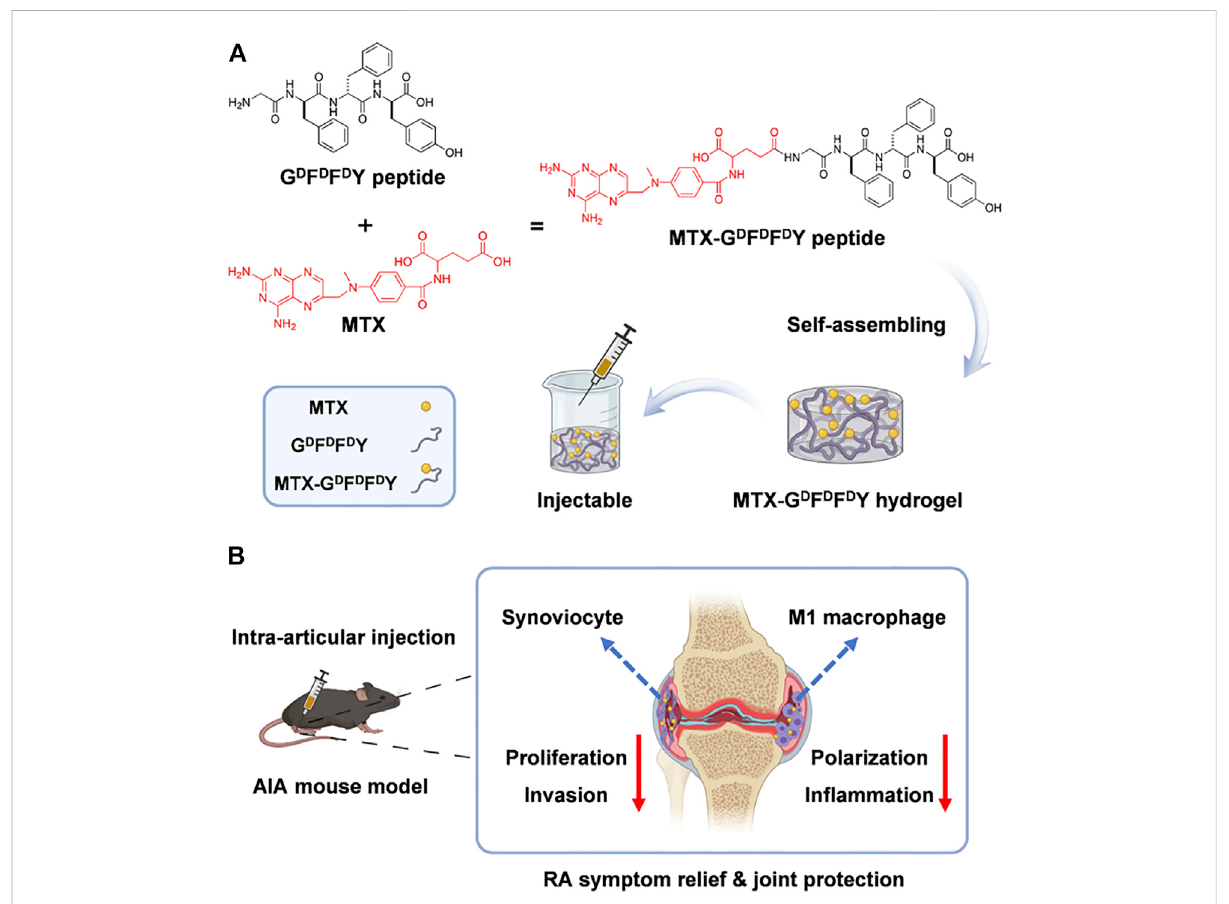
FIGURE 1 ThesynthesisofMTX-G D F D F D Yhydrogelsandtheiruseinthetreatmentofrheumatoidarthritis(RA)areshownschematically. (A) Theinteraction of the carboxyl groups in MTX with the deaminated glycine in peptides results in the conjugation of MTX with G D F D F D Y peptides. And the peptides could forminjectablehydrogels throughthestackingof π - π . (B) After beingintra-articularly injected into theknee joints ofadjuvant-induced arthritis (AIA)mice,thehydrogelscanconstantlyreleaseMTXduringbiodegration,andthusinhibitnotonlythepoliferationandinvasionofsynoviacytes, but also the polarization of poim fl ammtory M1 type macrophages, achieving a highly ef fi cent rheumatoid arthritis therapy by reducing joint in fl ammtion and destruction. Reproduced with permission from Ma et al., Materials Today Bio; published by Elsevier,